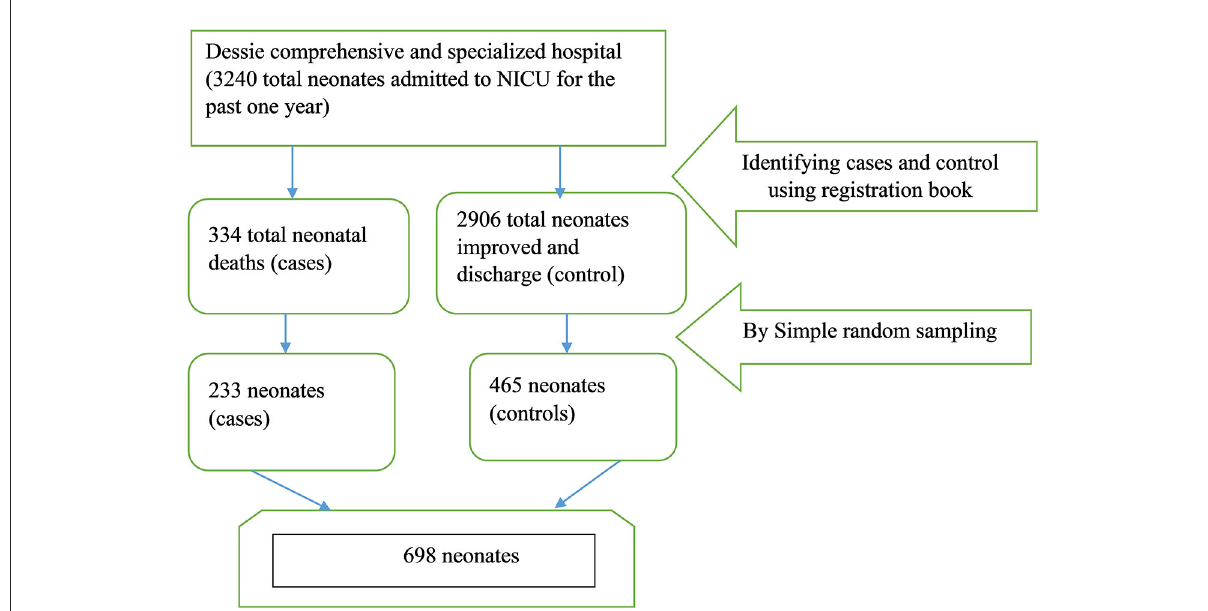
FIGURE1 A diagram of the sampling technique among NICU admitted newborns in Dessie Comprehensive and Specialized Hospital was presented from February 1/2020 to March 30/2020